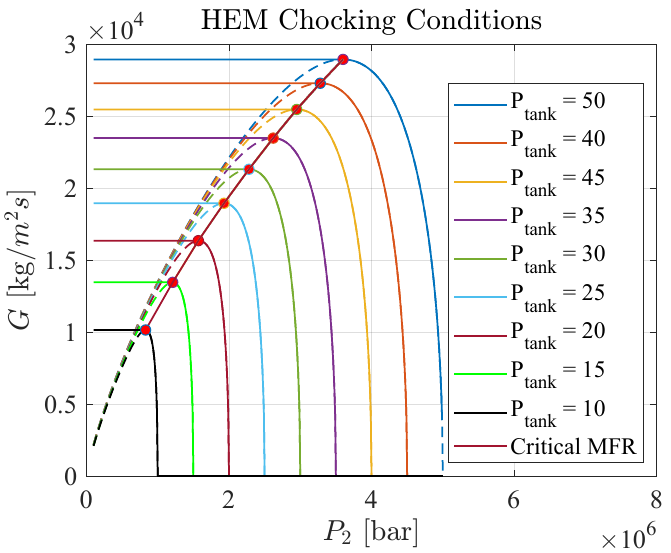
Figure 3. Mass flow rate computed with the HEM for the pressure range 1–50 bar, and a locus of critical mass flow rate for the pressure range 1–50